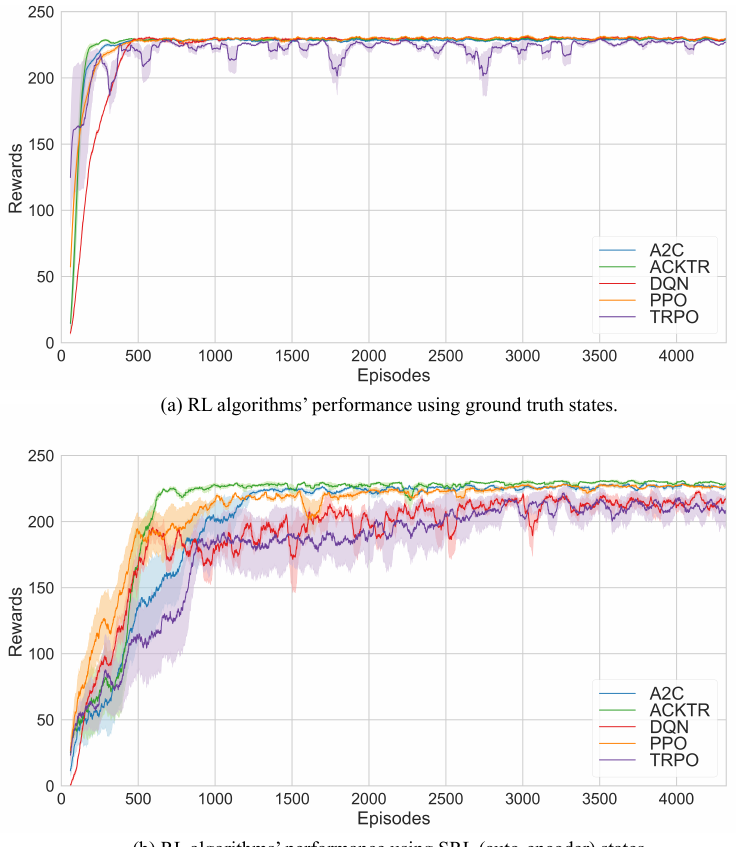
Figure 12. Performance (mean and standard error) on RL algorithms using SRL states with mobile robot one-random-target